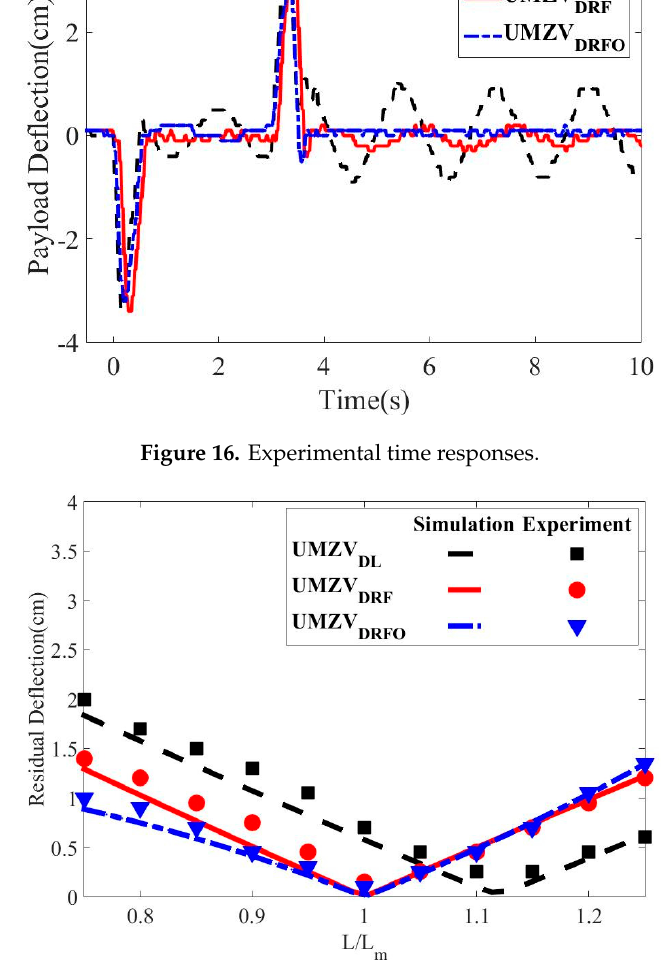
Figure 17. Experimental sensitivity to L/L m .